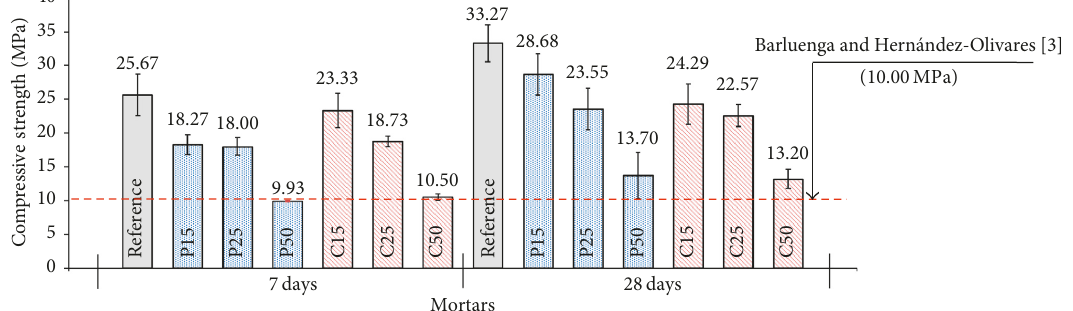
Figure 10: SLM compressive strength results. P: porecelain waste; C: ceramic waste.